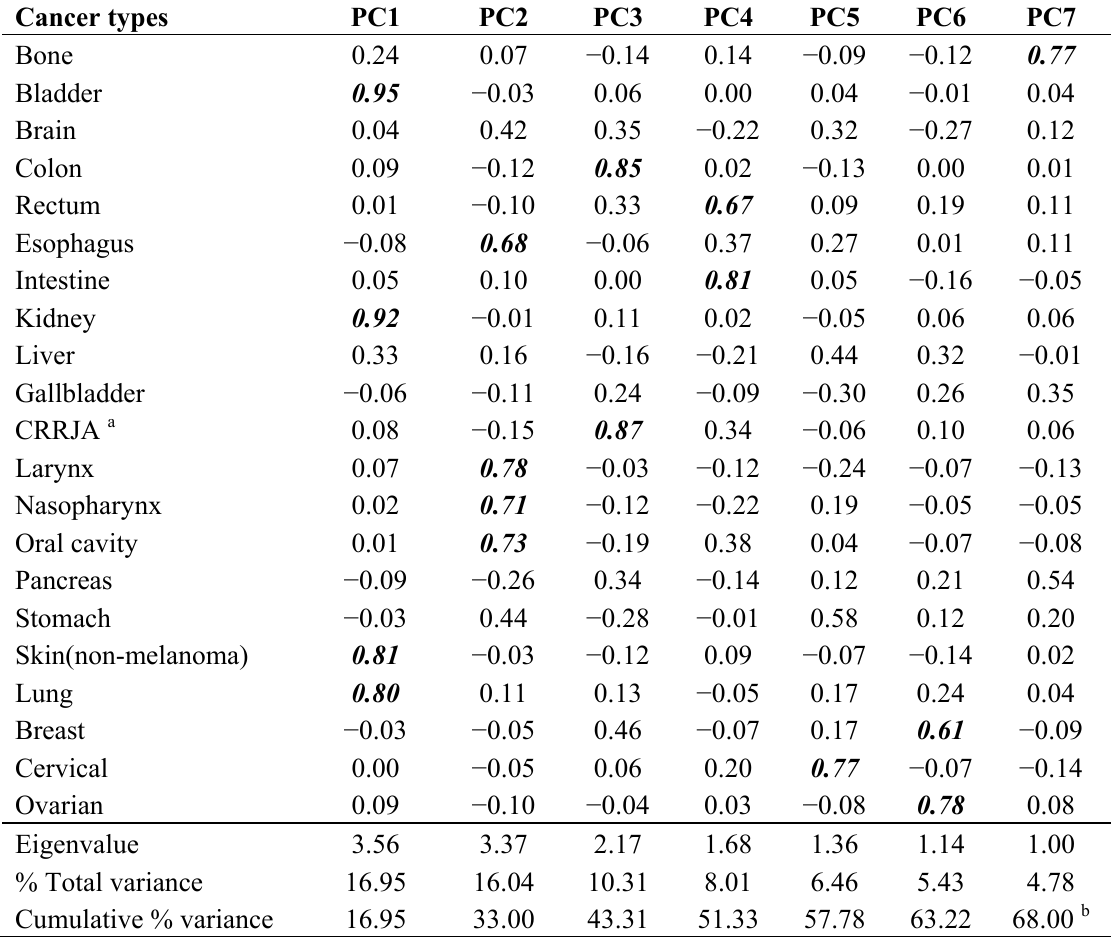
Table 1. Results from the principal component analysis for female cancer